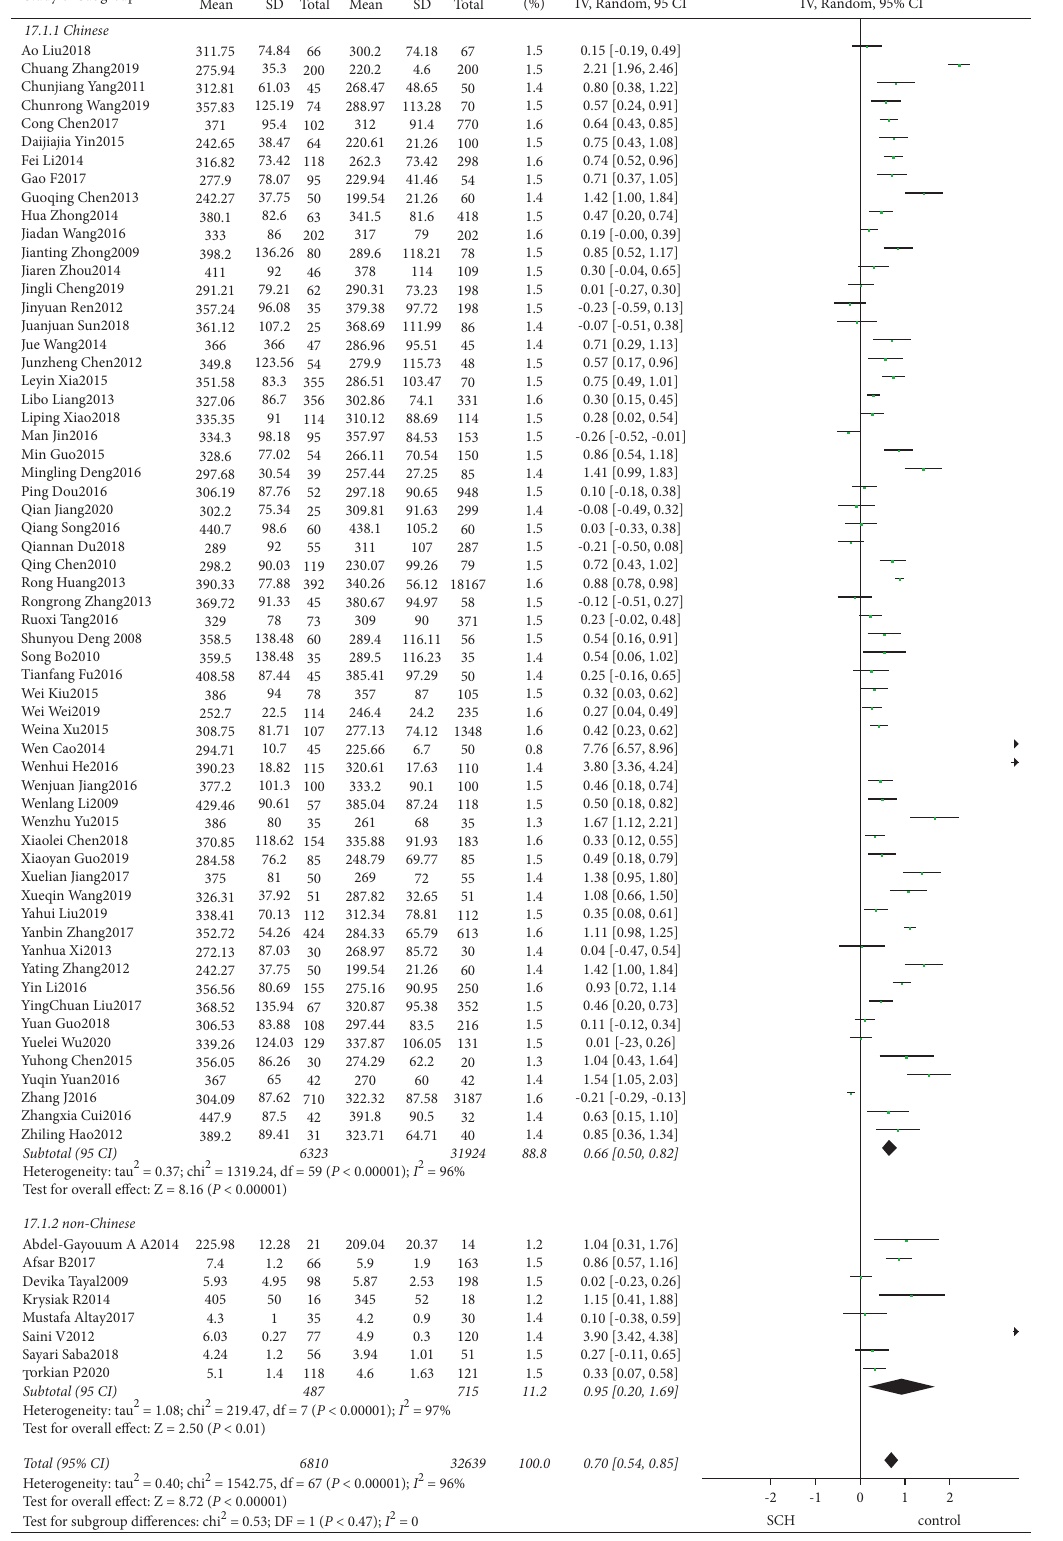
Test for overall effect: Z = 8.72 ( P <